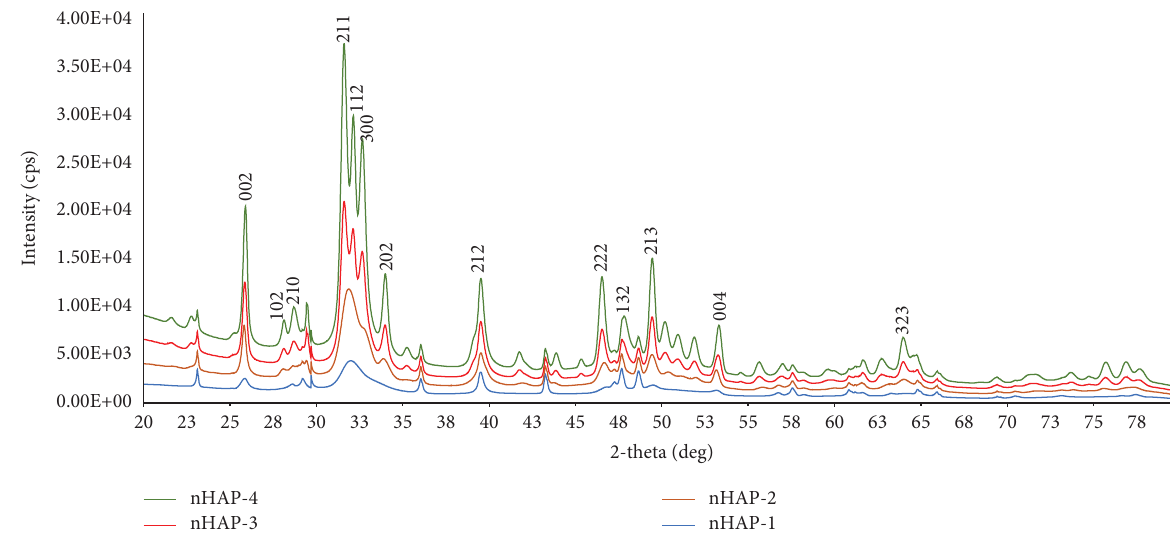
Figure 1: XRD difractograms of hydroxyapatite nanoparticles (nHAPs